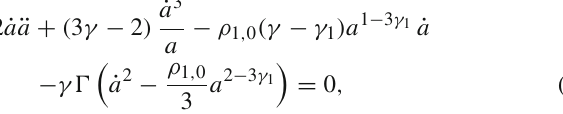
Particle creation rate ( (cid:2) ) of state ( w tot )